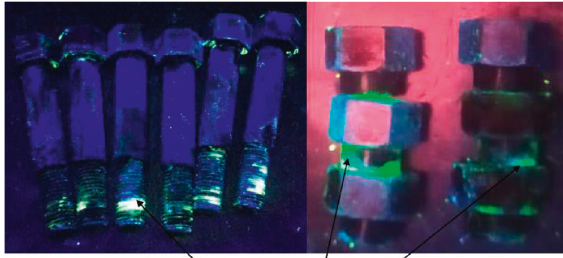
Figure 7: The test device of the second test. Table 2: Sample grouping and installation